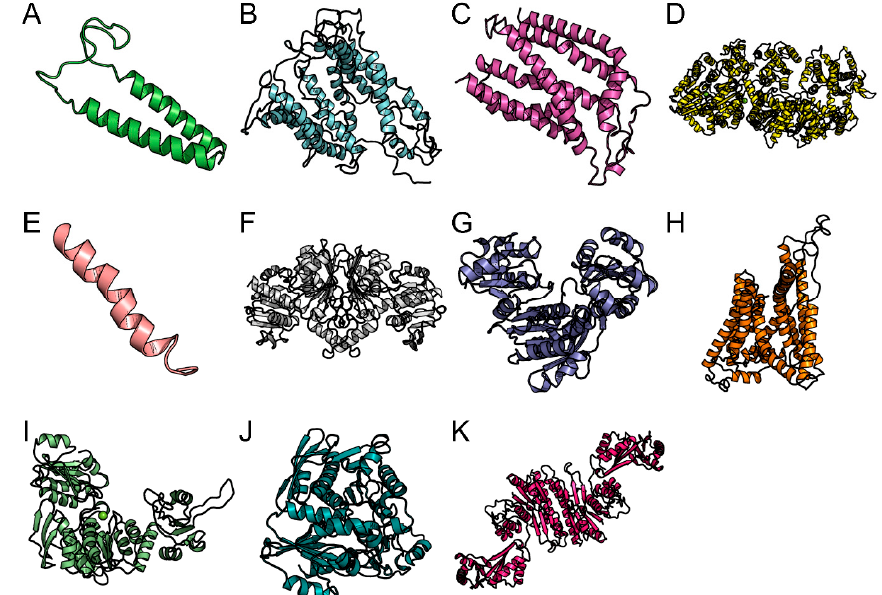
Figure 5. Predicted 3D structure of drug target proteins, preprotein translocase subunit SecG ( F. tularensis SCHU S4) ( A ). Preprotein translocase subunit SecY ( F. tularensis SCHU S4) ( B ). Twin-arginine translocase subunit TatC ( E. chaffeensis str. Arkansas) ( C ). Chromosomal replication initiator protein DnaA ( A. phagocytophilum HZ) ( D ). Cytochrome d ubiquinol oxidase subunit II ( R. rickettsii str. “Sheila Smith”) ( E ). Aspartate-semialdehyde dehydrogenase ( A. phagocytophilum HZ) ( F ). UDP- N -acetylmuramoylalanyl- D -glutamate-2,6-diaminopimelate ligase ( F. tularensis SCHU S4) ( G ). Preprotein translocase subunit SecY ( A. phagocytophilum HZ) ( H ). UDP- N -acetymuramoyl-tripeptide ( B. burgdoferri B31) ( I) . UPD- N -acetymuramate- L -alanine ligase ( F. tularensis SCHU S4) ( J ). Aspartate kinase ( E. chaffeensis str. Arkansas) ( K ).